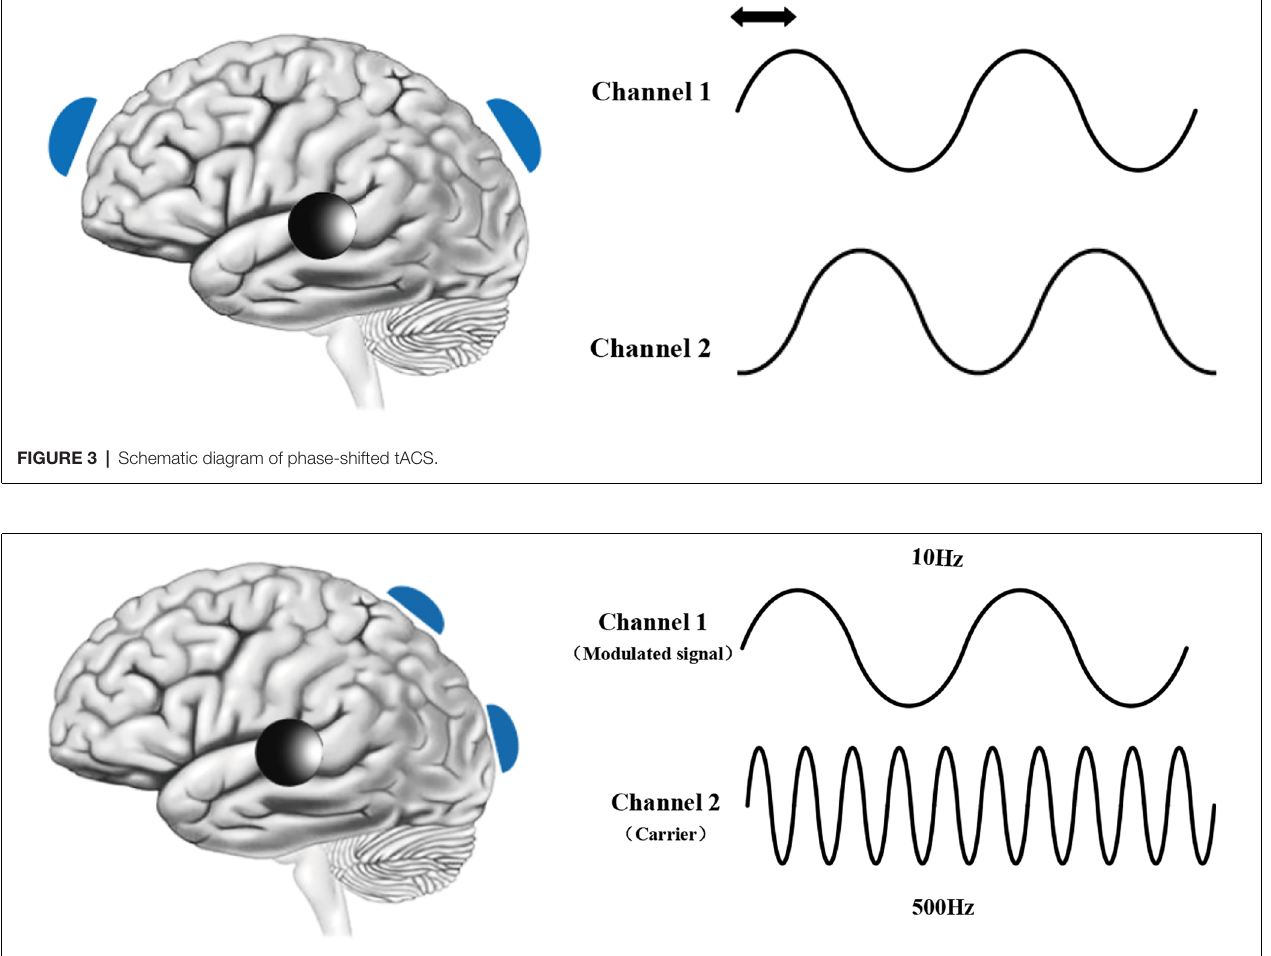
FIGURE 4 | Schematic diagram of